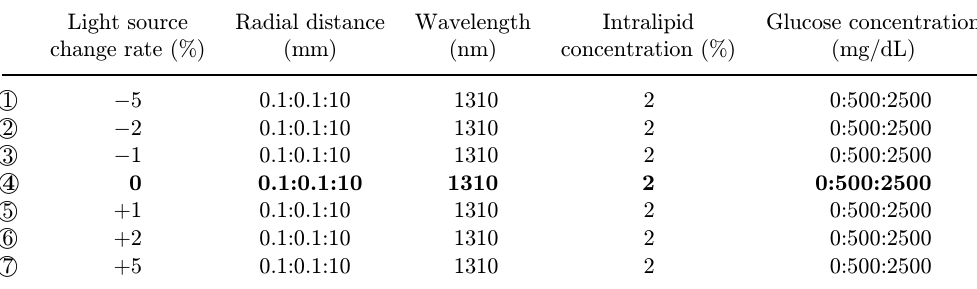
Table 7. Simulating parameters for light source drift.